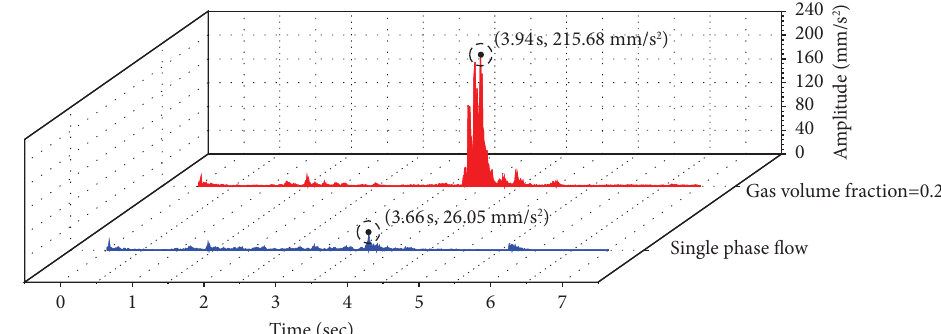
Figure 9: Diagram for comparison of structural response between single-phase fow and two-phase fow.